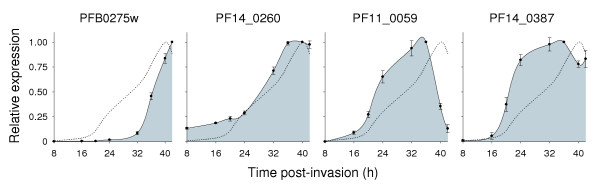
Stage-dependent gene expression of four putative members of the drug:H+ antiporters-1 family (a subfamily of the MFS), throughout the intraerythrocytic cycle of P. falciparum. The analysis was carried out as described in the legend to Figure 4.